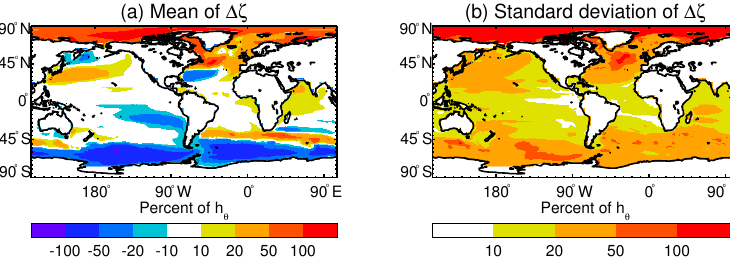
Figure 1. (a) Ensemble mean and (b) ensemble standard deviation of CMIP5 AOGCMs for the projected change (cid:49)ζ in ocean dynamic sea level for 2081–2100 with respect to 1986–2005 under the mid-range scenario RCP4.5, expressed as percentages of ensemble-mean global-mean sea-level rise h θ due to thermal expansion for the same